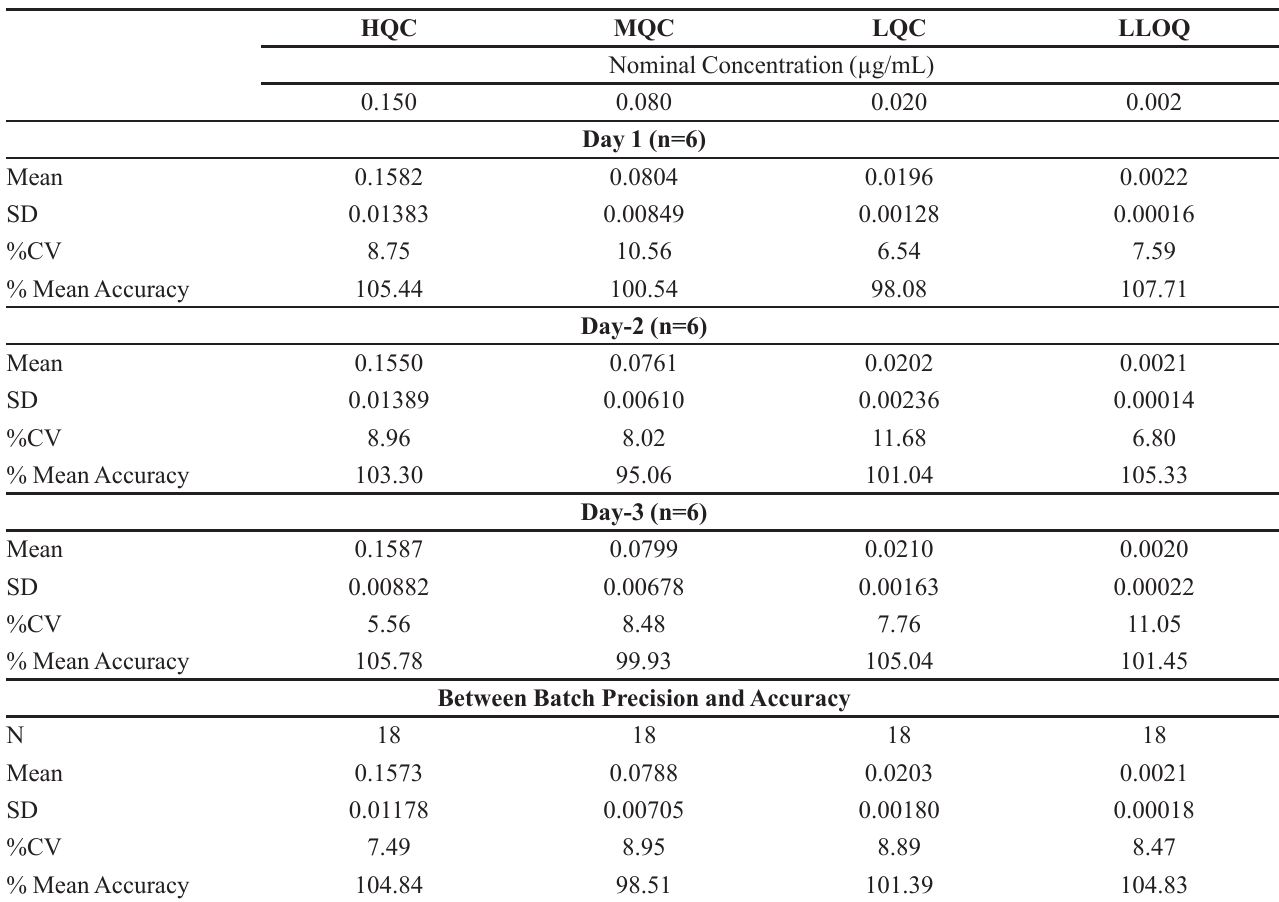
TABLE VII - Precision interday and intraday data